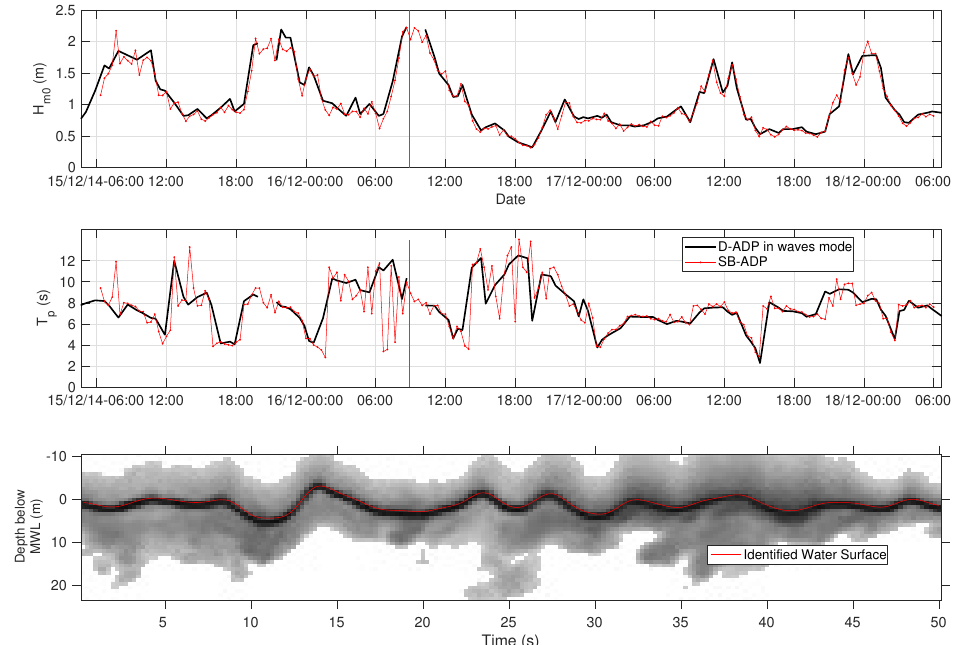
Figure 6. Time series (15–18 December 2014) of significant wave height, H m 0 (top), and peak period, T p (middle), as measured above the TEC by (black line) the benchmark instrument, the AWAC D-ADP operating in “waves mode” and (red line) a vertically-orientated SB-ADP. The vertical grey line shows the starting time of an example surface tracking analysis (bottom) showing the background amplitude return signal from the SB-ADP and the corresponding detected surface (red